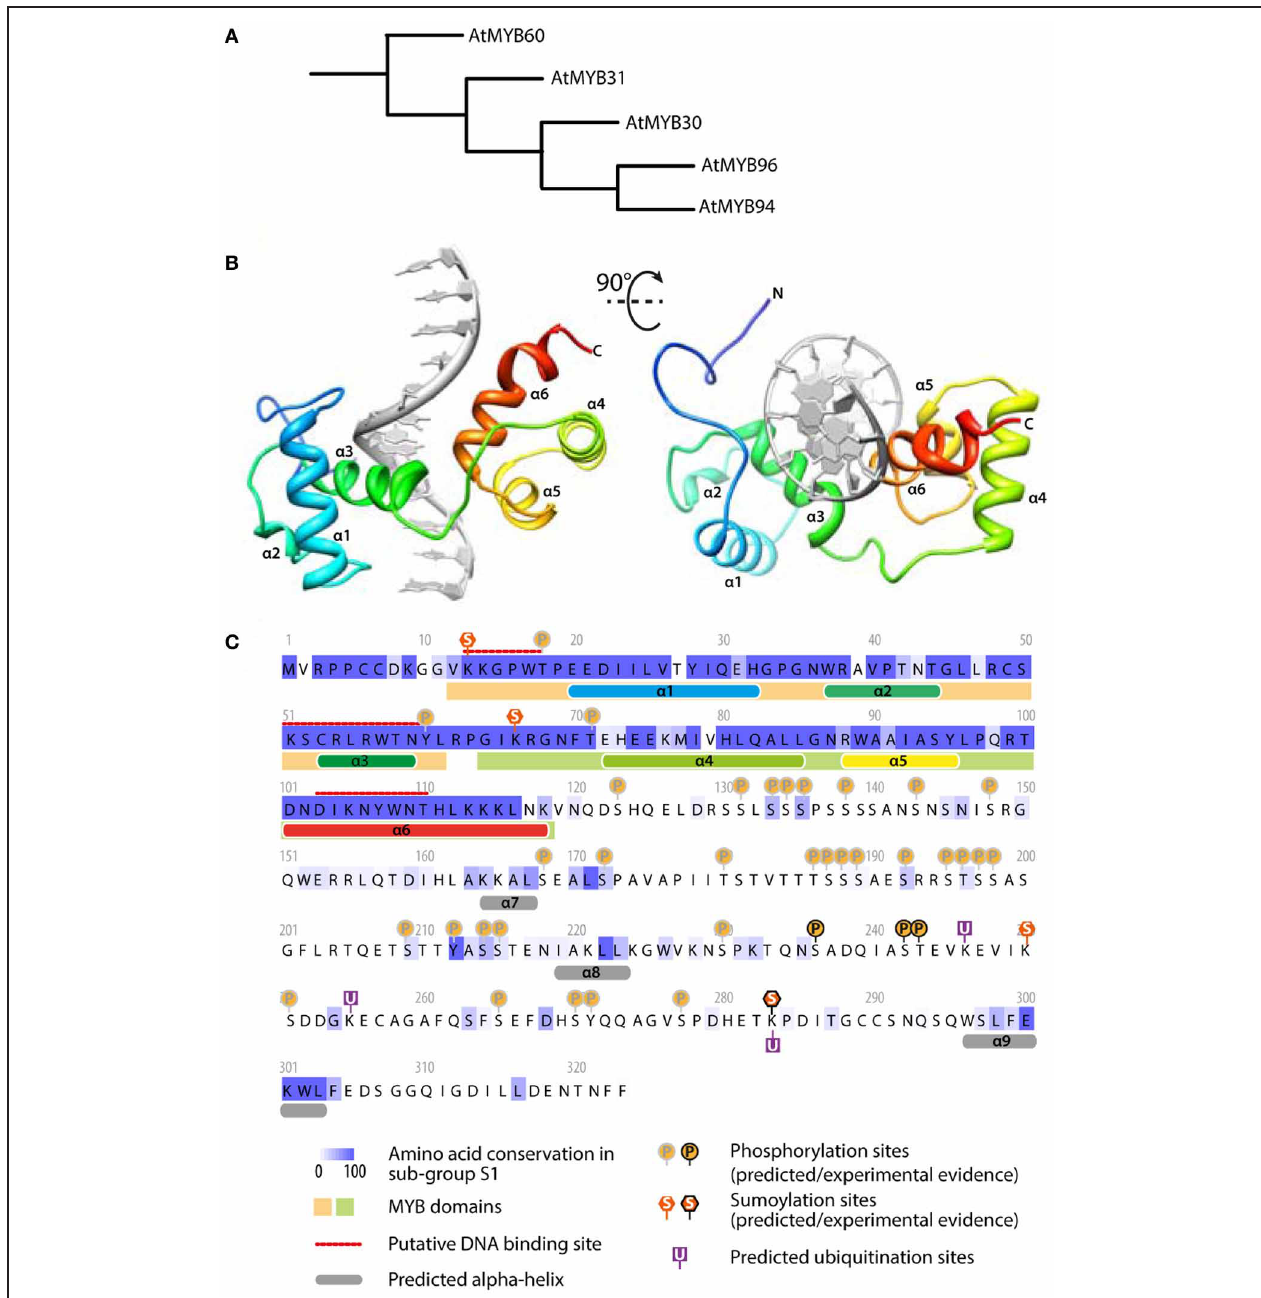
protein. The conservation between members of subgroup S1 was inferred from a MUSCLE alignment and colored using JALVIEW. Alpha helices and DNA binding sites were predicted using the I-TASSER server. MYB domains were identified using INTERPROSCAN. Phosphorylation, sumoylation and ubiquitation sites were predicted using PhosphAt, Sumoplot and Ubpred